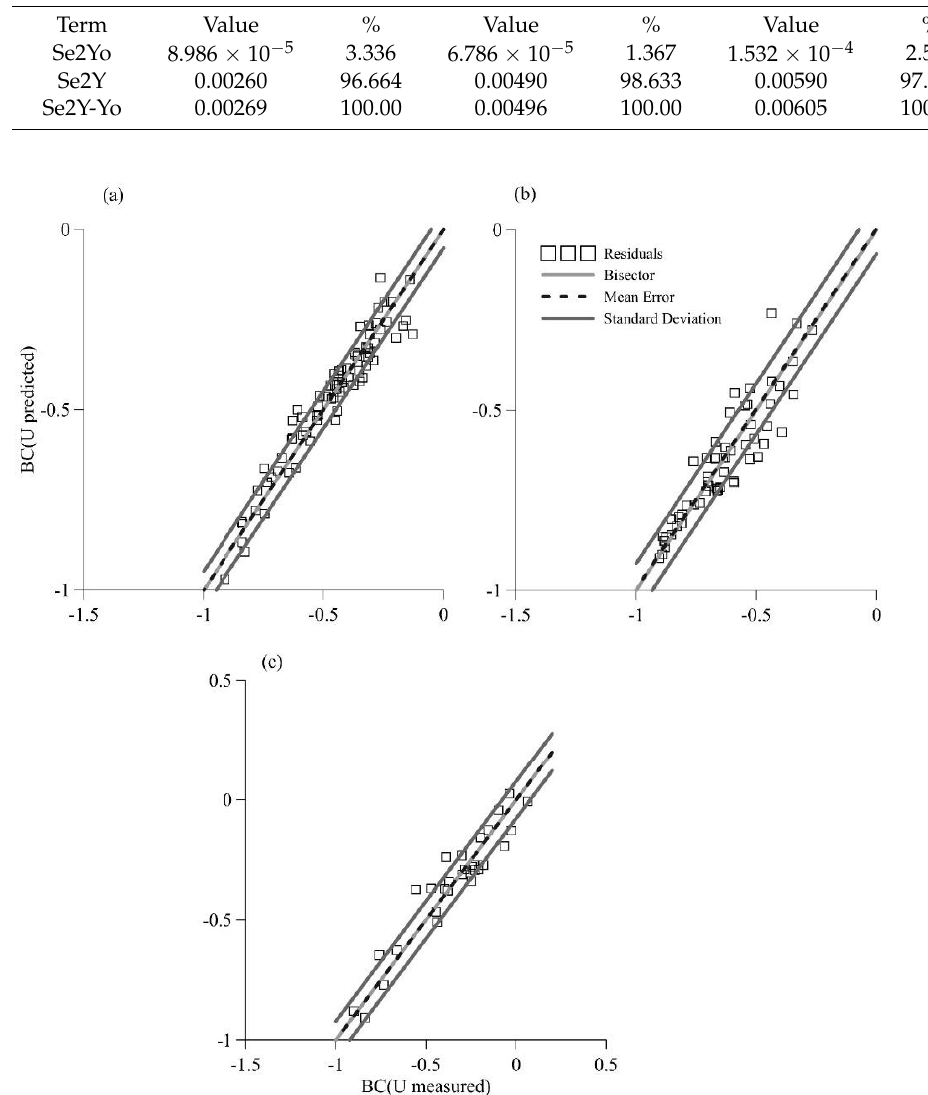
Figure 4. Plot of observed and predicted velocity values: ( a ) Cascade ; ( b ) Step-pool ; ( c ) Plane-bed .